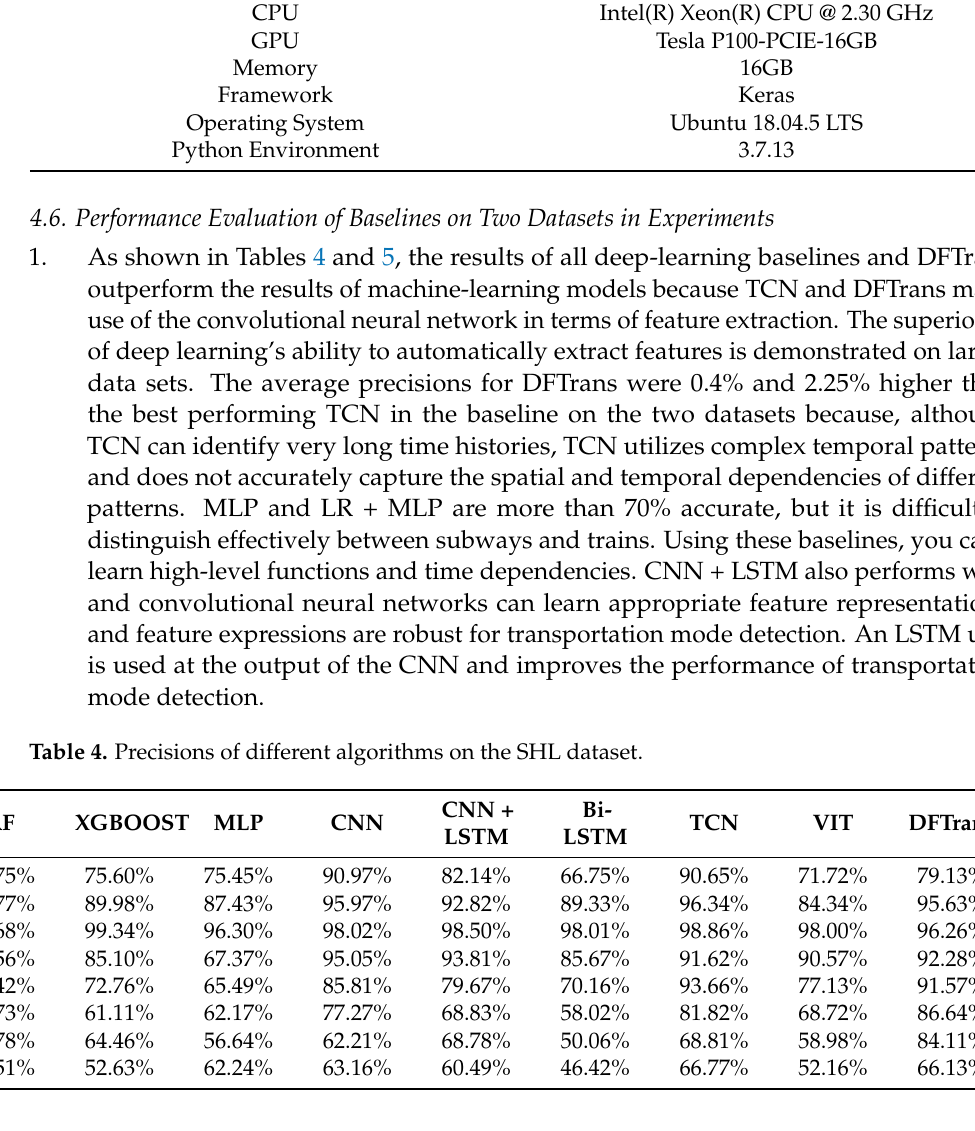
Table 5. Precisions of different algorithms on the HTC